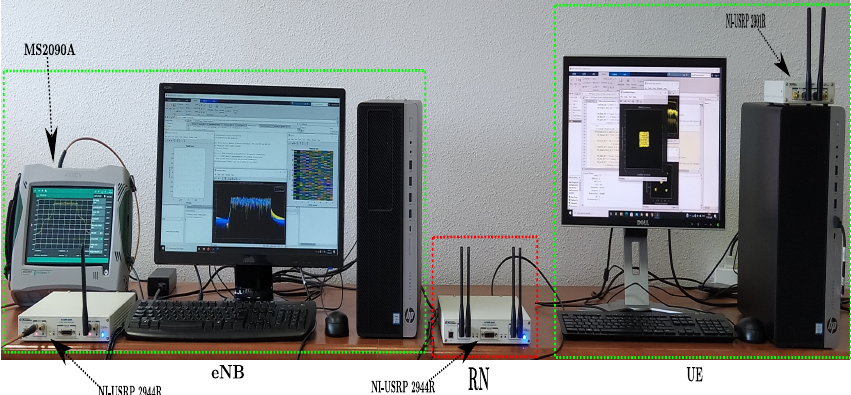
Figure 5. Testbed Environment for A&F and D&F Relay Nodes system.